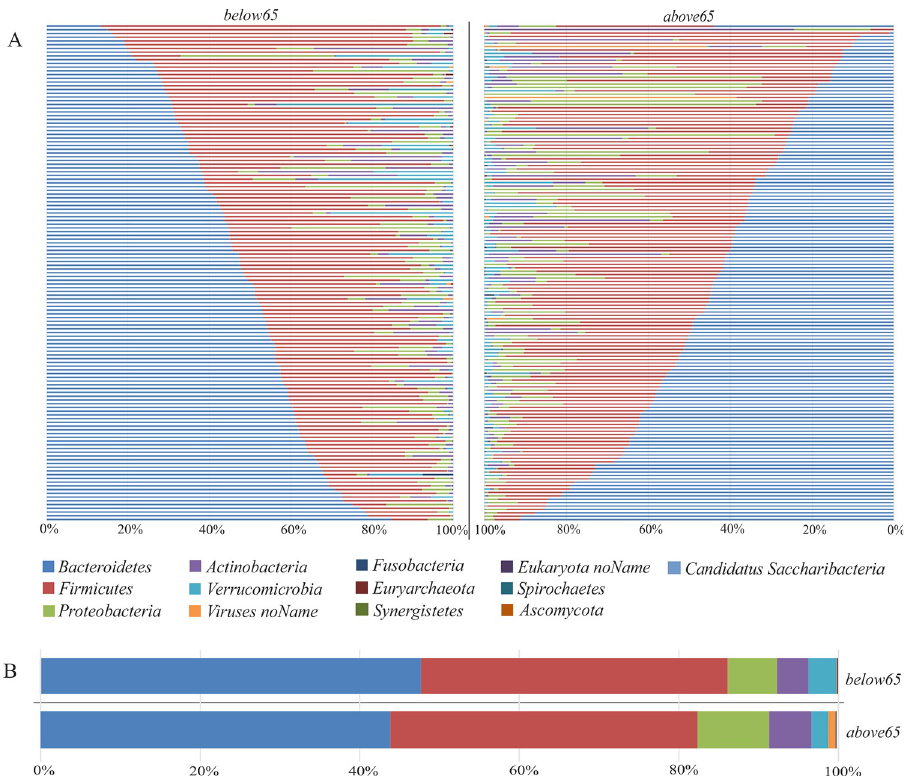
Fig 1. Taxonomic characterization of the intestinal microbiome. Relative abundances of microbiota at phylum level for each study subject (A) and averaged for study groups (B). Above65 (patients aged 65 years and above; n = 145), below65 (patients below 65 years of age; n =